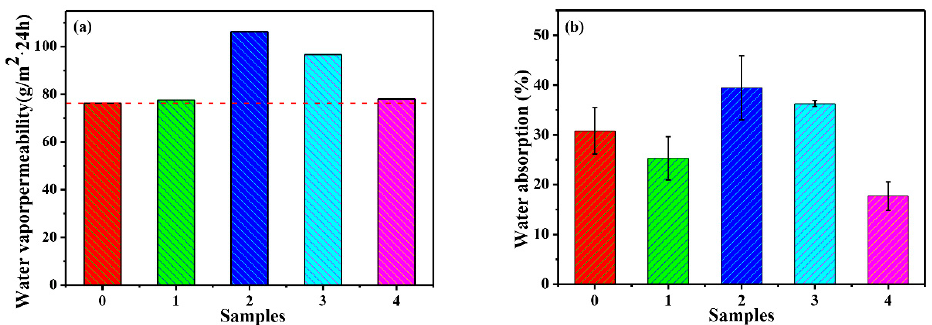
Figure 12. ( a ) Effects of fillers on water vapor permeability and ( b ) water resistance of composite films ( 0. PMA, 1. PMA/SiO 2 , 2. PMA/KH550-SiO 2 , 3. PMA/KH560-SiO 2 and 4. PMA/KH570-SiO 2 ).